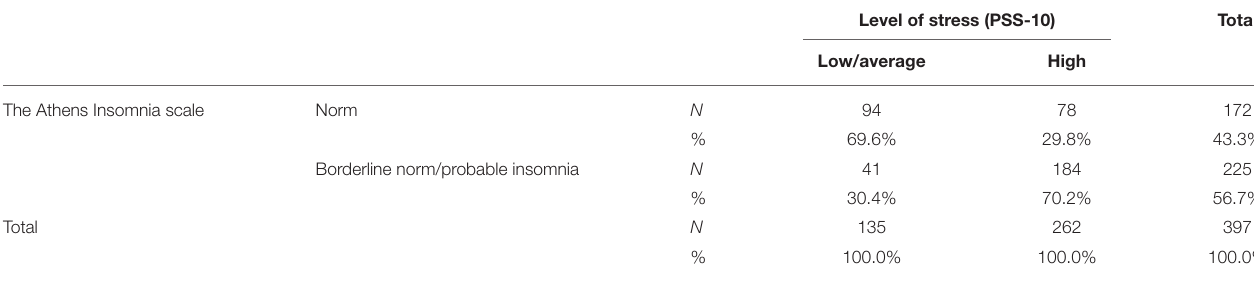
TABLE 1 | Occurrence of sleep disorders and the level of perceived intensity of stress.